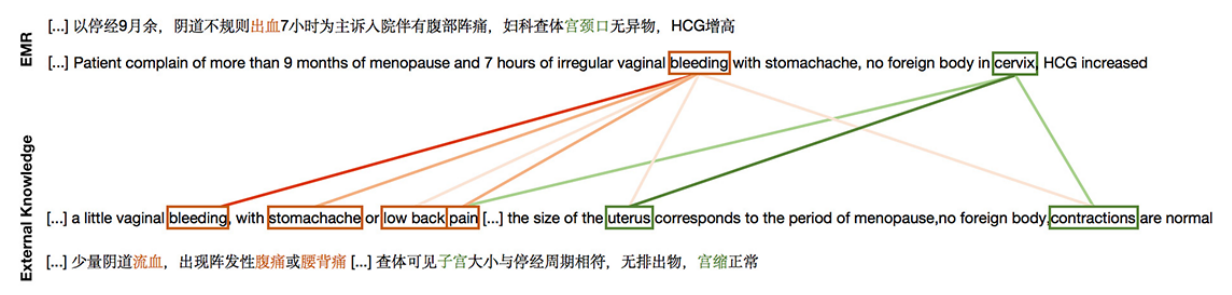
Figure 5. Visualization of attention in knowledge aggregator (knowledge